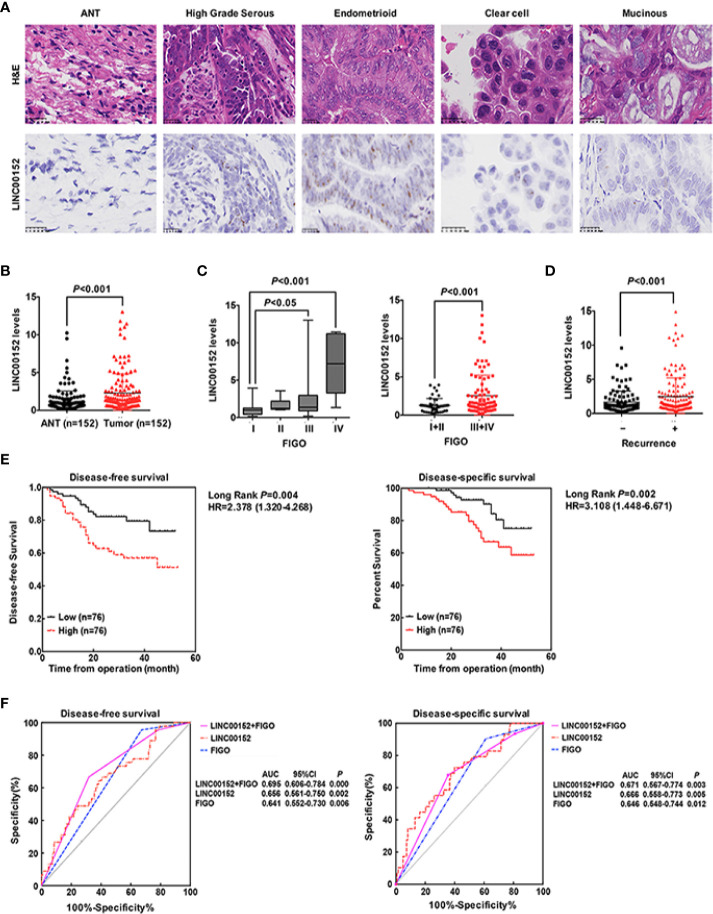
LINC00152 is upregulated in ovarian cancer and predicts poor clinical outcomes. (A) The expression of LINC00152 detected by in situ RNA hybridization in adjacent tumor tissues (ANTs) and different subtypes (high grade serous, endometrioid, clear cell and mucinous) of ovarian carcinomas. Scale bars = 25 µm. (B) The expression of LINC00152 detected by Real-time qPCR in 152 pairs of the adjacent tumor tissues (ANTs) and ovarian tumor tissues. P < 0.01. (C) The expression of LINC00152 detected by Real-time qPCR divided by FIGO stage in 152 cases of ovarian cancers. Left: The cases were divided into Stage I, II, III and IV. Right: The cases were divided into Stage I+II and Stage III+IV. P < 0.05. (D) The expression of LINC00152 detected by Real-time qPCR in cases with or without recurrences. P < 0.01. (E) The disease-free survivals (DFS) and the disease-specific survivals (DSS) of patients divided by expressions of LINC00152. The expression of LINC00152 was divided by the median value. The HR and the 95% CI were shown. P < 0.01. (F) The ROC curves for of LINC00152, FIGO and the combination of LINC00152 and FIGO for disease-free survivals (DFS) and the disease-specific survivals (DSS). The areas under curves (AUC) were shown. P < 0.01.